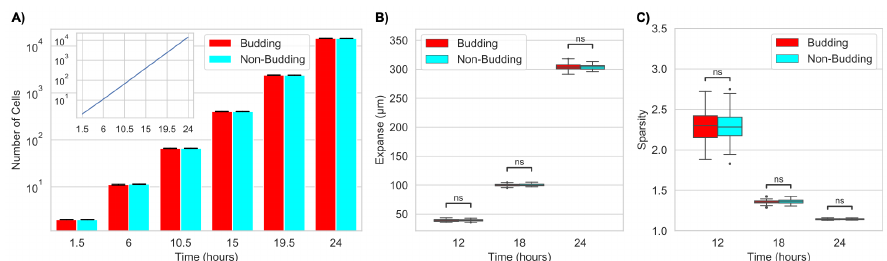
Figure 3. Population Growth, Expanse and Sparsity of Simulated Yeast Colonies in Nutrient-Rich Conditions. ( A ) Colony growth is exponential with doubling time ∼ 105 min (inset). Bar plots represent average number of cells in each colony across all 50 simulations for both budding and non-budding colonies under nutrient-rich conditions calculated at 4.5 h intervals; ( B ) Colony expanse increases over time for both budding and non-budding colonies; ( C ) Colony sparsity decreases to 1 (implying that the colony is becoming more circular) as the size of the colony increases over time for both budding and non-budding colonies. (See Section 2.1.1 for